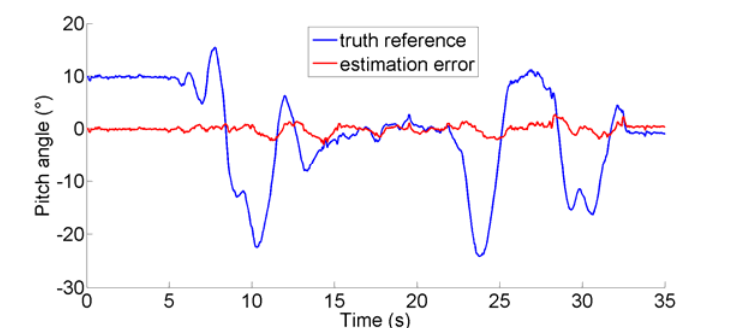
Figure 8. Pitch angle time functions, truth reference and estimation error by the EKF.